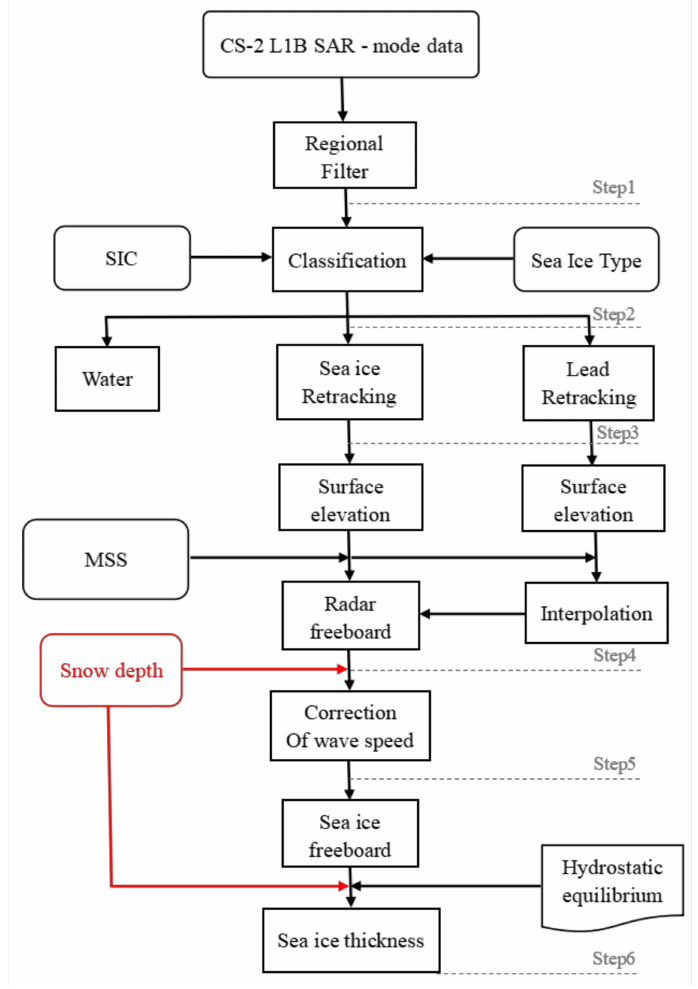
Figure 6. Flowchart of SIT